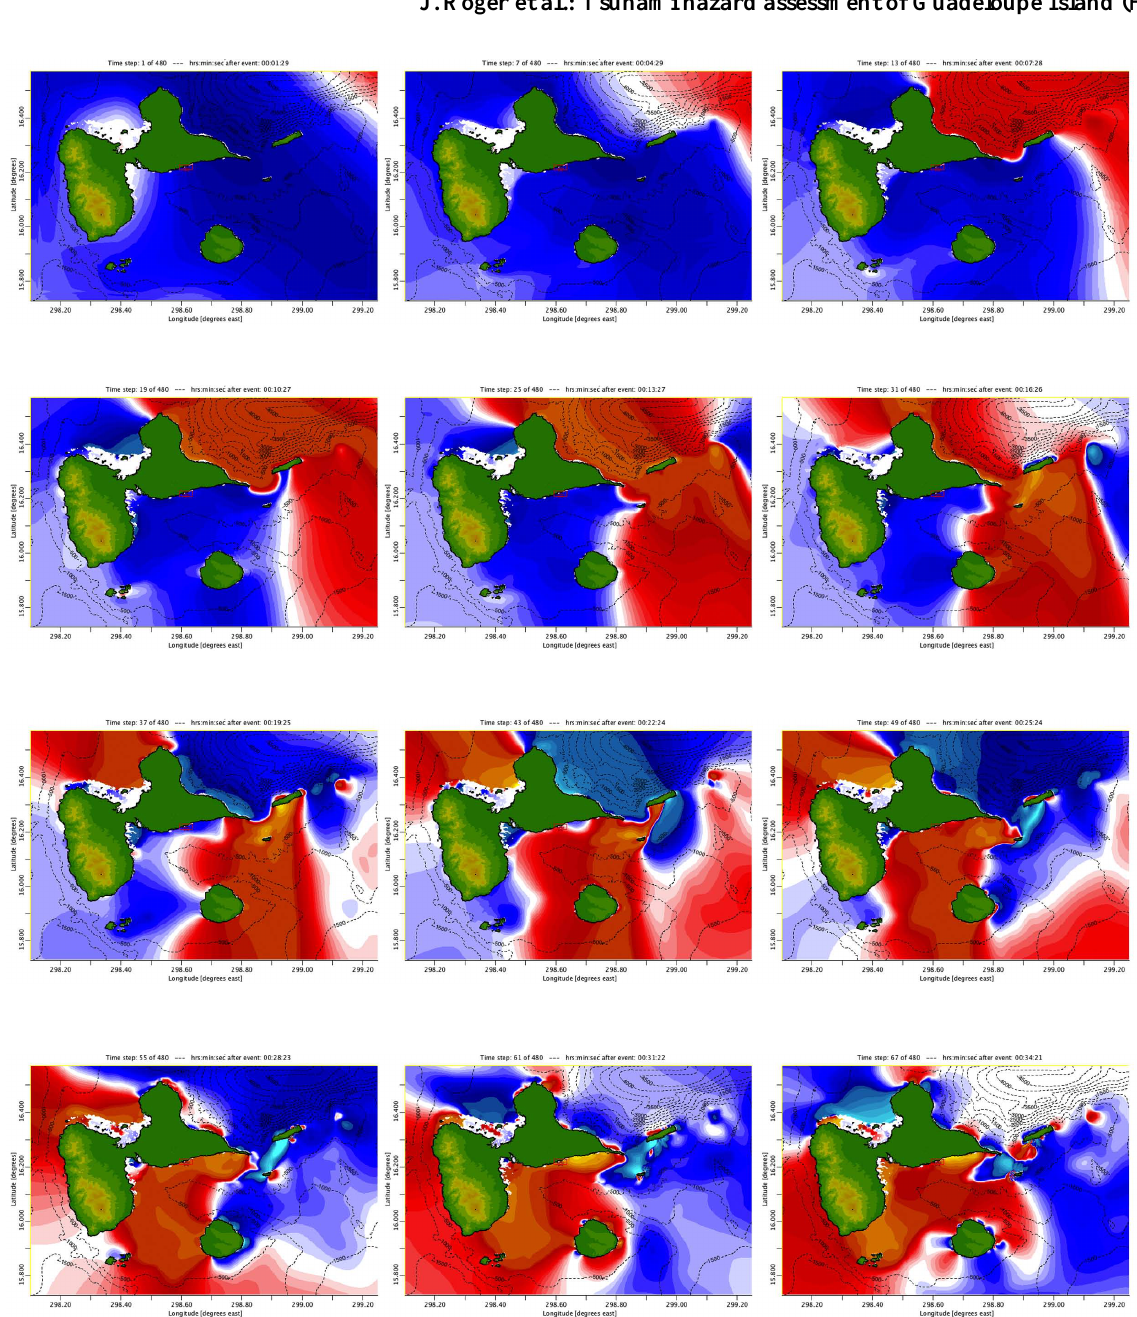
Fig. 8. Tsunami propagation towards the Guadeloupian Archipelago: focus on the main tsunami front wrapping around La D´esirade and Petite-Terre Islands and refocusing in two